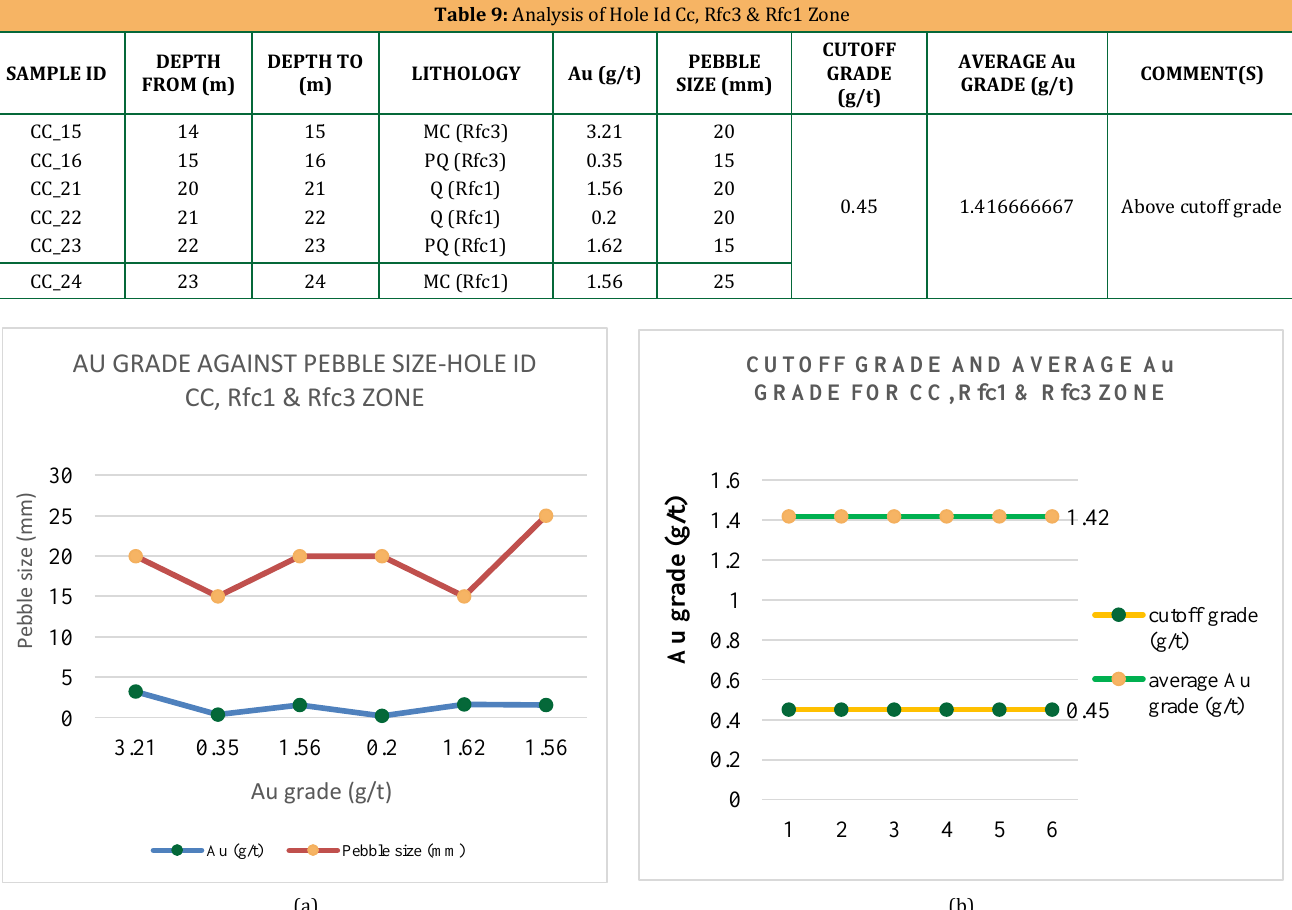
Figure 8: (a) Pebble size against Au Grade-Hole ID CC, Rfc1 & Rfc3 zone; (b) Cutoff grade and average Au grade-CC, Rfc1 & Rfc3 zone Table 10: Analysis for Hole Id Ce